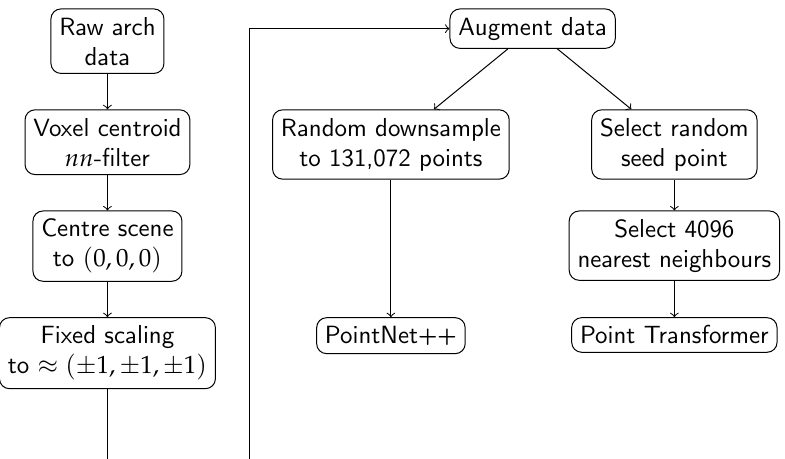
Figure 5. Overview of the processing steps, from the raw arch data to the data fed to the machine learning